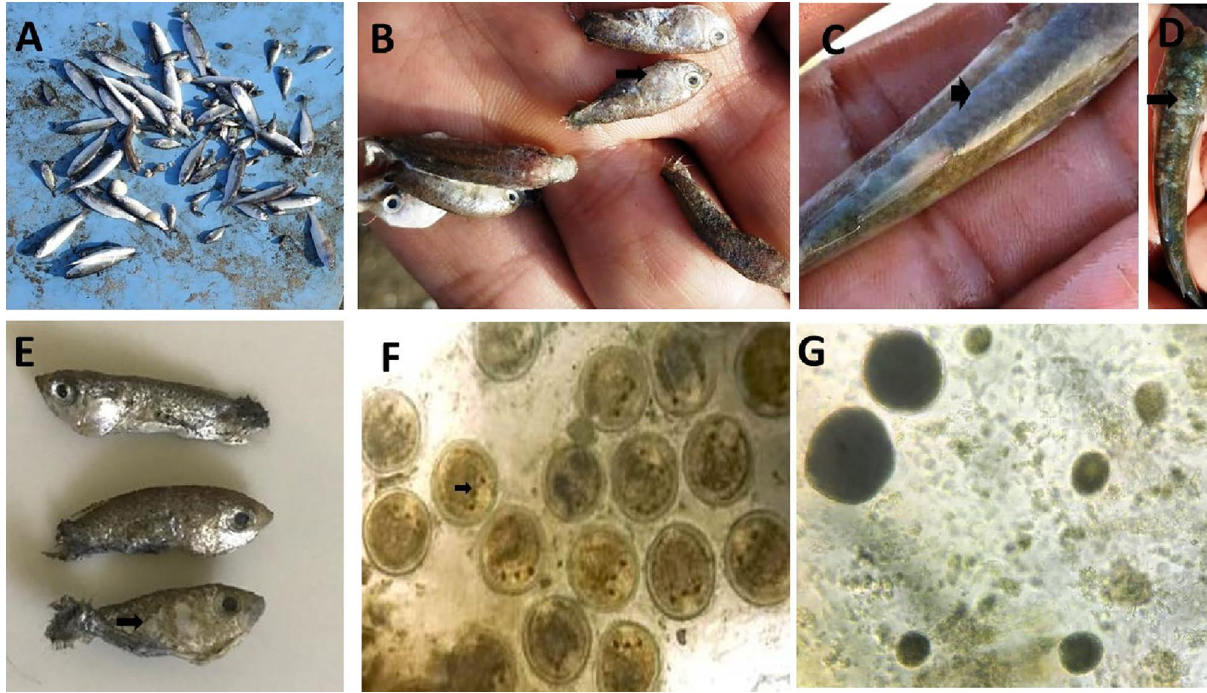
Figure 1. Mass mortality in Liza carinata fish with concurrent infection with Cryptocaryon irritans and Amyloodinium ocellatum infection in marine fish farm. ( A ) Mass mortalities in farmed Liza carinata ; ( B ) white spots as pinhead-size on skin; fins and gills of small fish due to C. irritans ; ( C – E ) sloughing of the skin of small fish with velvet formation due to Amyloodinium ocellatum ; ( F ) C. irritans with the stage present on the scraping smears was the trophont, note the cytoplasm appeared opaque in color with 3–4 macronucleus, ( G ) Amyloodinium ocellatum small to large in size rounded to pear in shape with opaque and dark in color